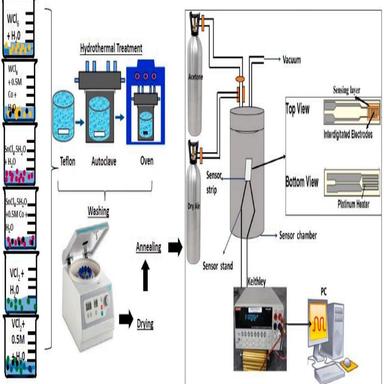
The hydrothermal synthesis of the of n-type semiconductor nanostructures including WO3, SnO2, VO2 and their cobalt doped counterparts and gas sensing measurement. (For interpretation of the references to color in this figure legend, the reader is referred to the web version of this article.)